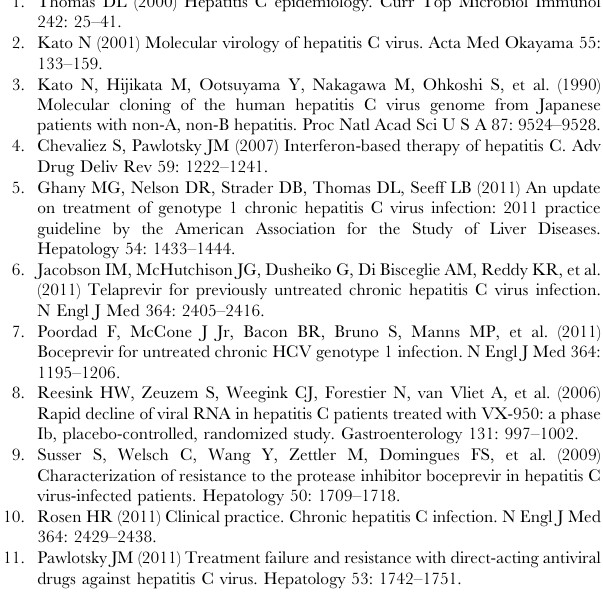
(lower panel) in combination with RBV for 72 hrs and subjected to RL assay. (C) Effect of N-89 or N-251 in combination with IFN- a and RBV on OR6 assay. OR6 cells were treated with N-89 (upper panel) or N-251 (lower panel) in combination with IFN- a and RBV for 72 hrs and subjected to RL assay. (TIF) Figure S5 Effects of N-89 or N-251 in combination with IFN- a and/or RBV on the growth of ORL8 or OR6 cells. ORL8 cells (A, B) or OR6 cells (C, D) were treated with N-89 (A, C) or N-251 (B, D) in combination with IFN- a for 72 hrs and subjected to the cell counting. The cell counting was carried out as described in the Supporting Materials and methods. (TIF) Figure S6 Selection of genes whose expression levels were commonly upregulated or downregulated in the N- 89-treated OR6 and ORL8 cells. (A) Genes whose expression levels were upregulated at ratios of more than 2 in the case of OR6( 2 ) versus OR6(N-89) or ORL8( 2 ) versus ORL8(N-89) were selected. 4 genes upregulated commonly in the N-89-treated cells were listed. (B) Genes whose expression levels were downregulated at ratios of less than 0.5 in the case of OR6( 2 ) versus OR6(N-89) or ORL8( 2 ) versus ORL8(N-89) were selected. 5 genes down- regulated commonly in the N-89-treated cells were listed. (TIF) Text S1.